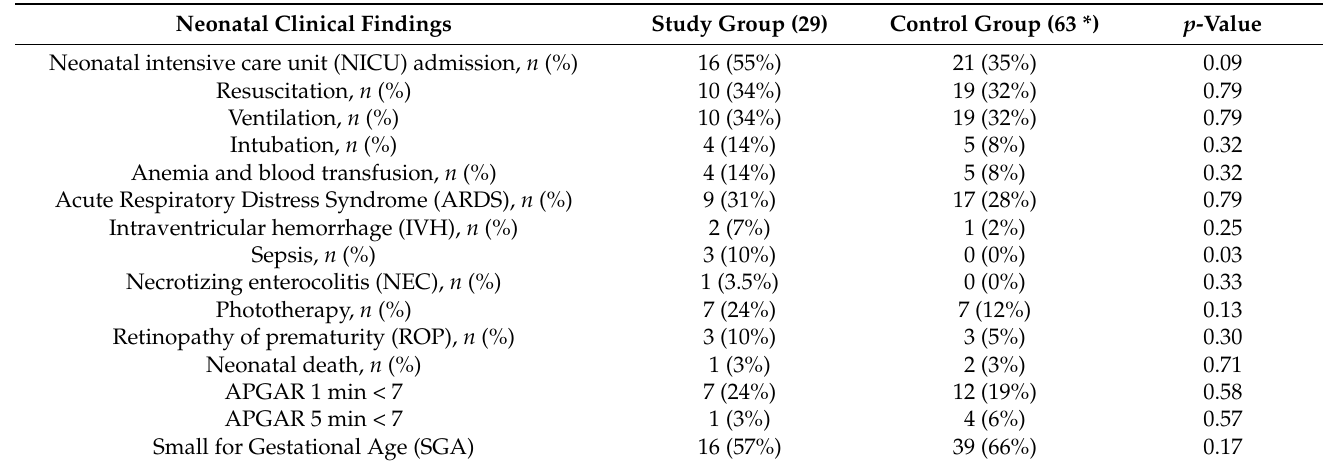
Table 3. Neonatal findings in study and control group.